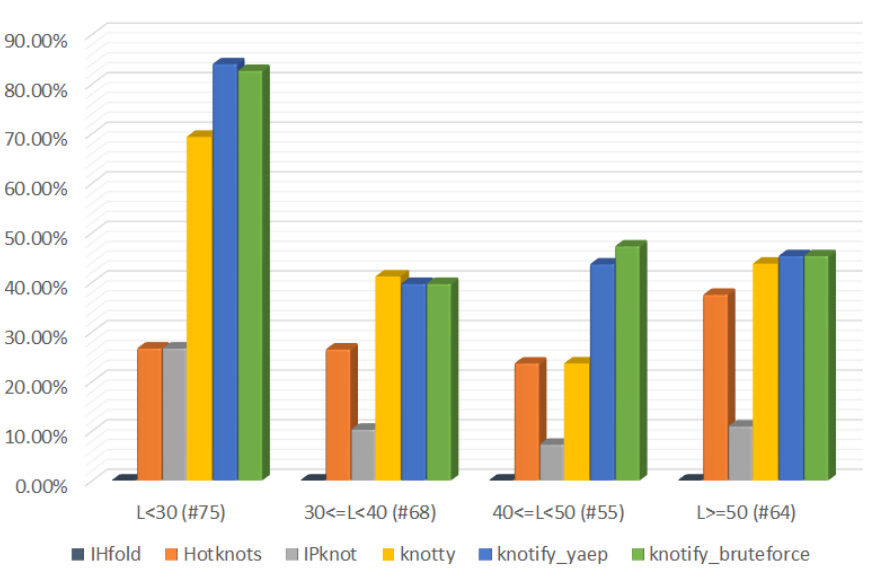
Figure 9. Percentage of pseudoknot’s core stems exact prediction per platform and sequence